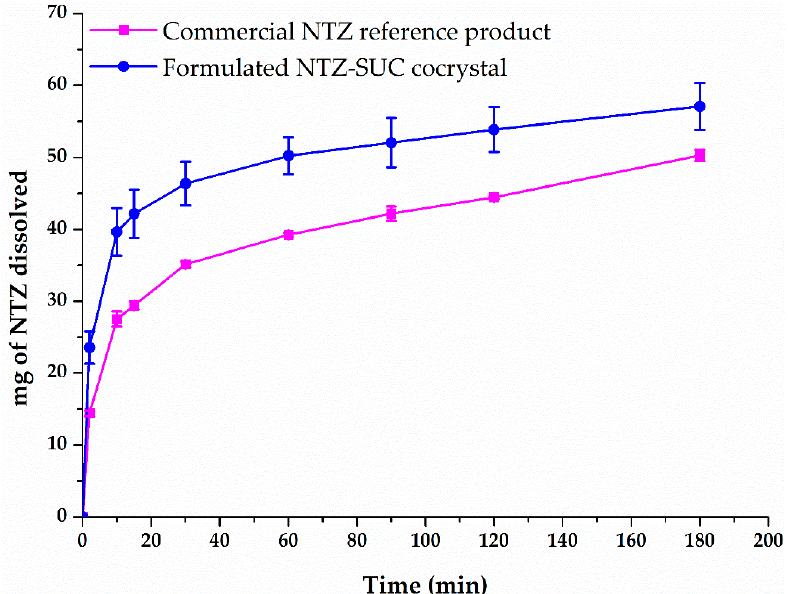
Figure 10. Powder dissolution profiles of a commercially available formulated NTZ medicine and the formulated powder of NTZ-SUC cocrystals with Methocel ® 60 HG (5% w / w ) in pH 7.5 PBS at 37 ± 0.5 °C ( n = 3 ± SD).